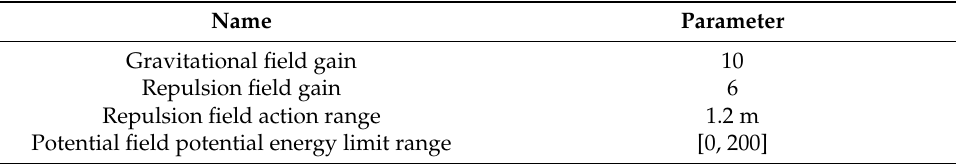
Table 4. Virtual potential field parameters.